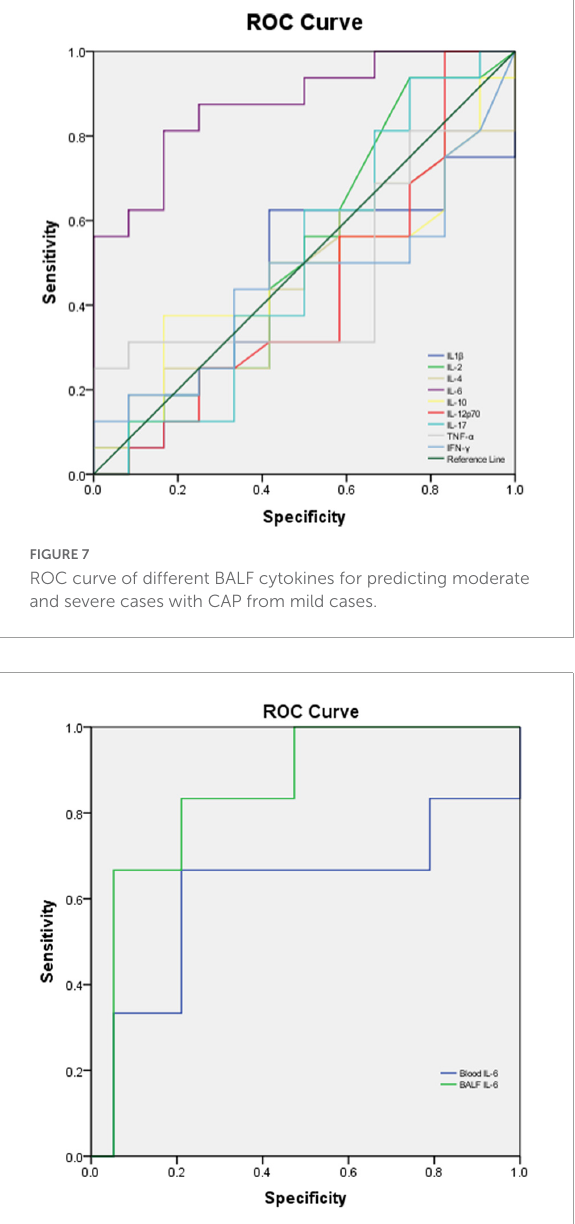
FIGURE8 ROC curve of blood IL-6 and BALF IL-6 levels for differentiating severe and moderate cases from mild cases in CAP. N = 25, Blood IL-6: AUC = 0.614, p = 0.418; BALF IL-6: AUC = 0.851, p = 0.011, p <